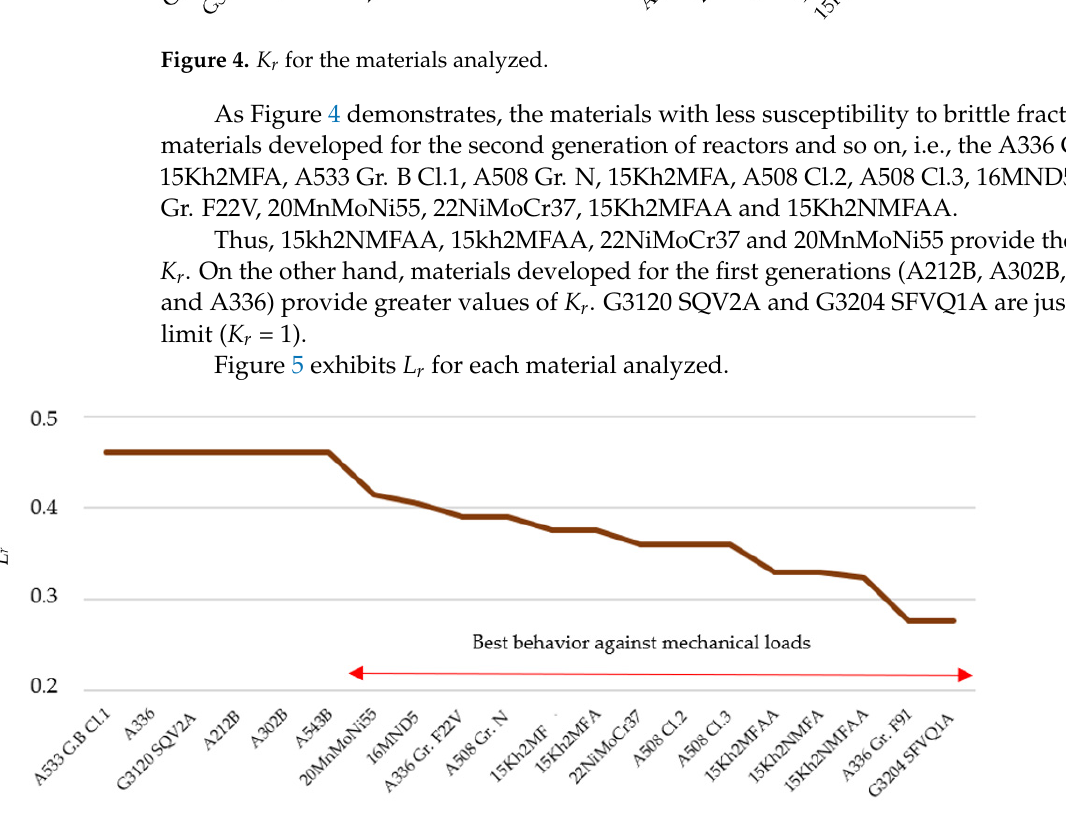
Figure 5. L r for every analyzed